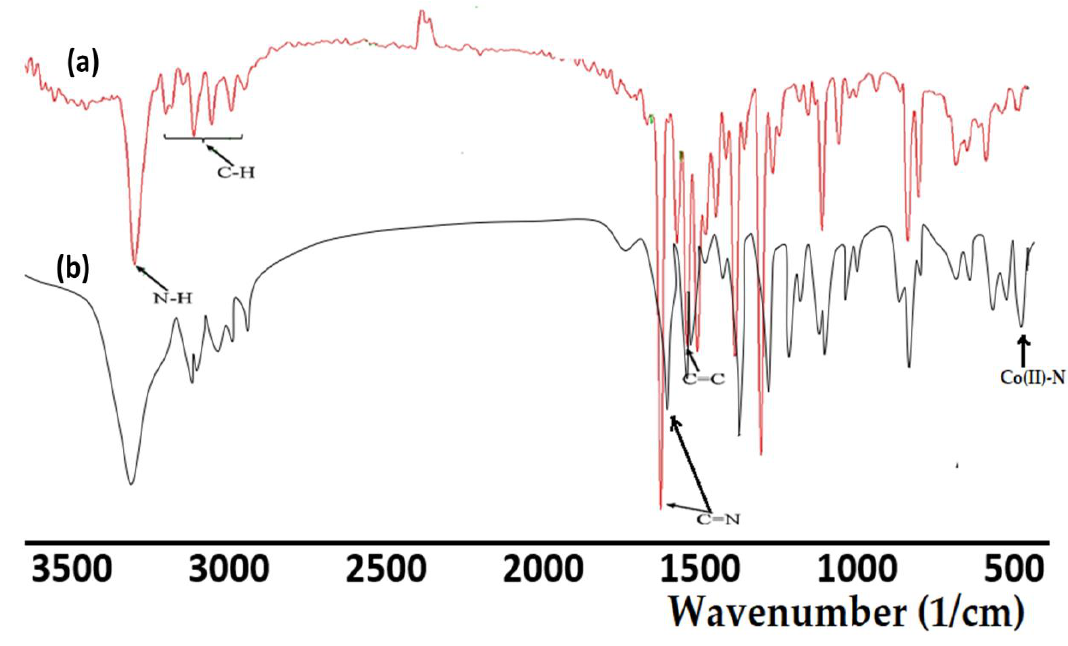
Figure 2. FTIR spectra of: ( a ) the tridentate pyrazole ligand, and ( b ) the Co(II)/pyrazole complex.